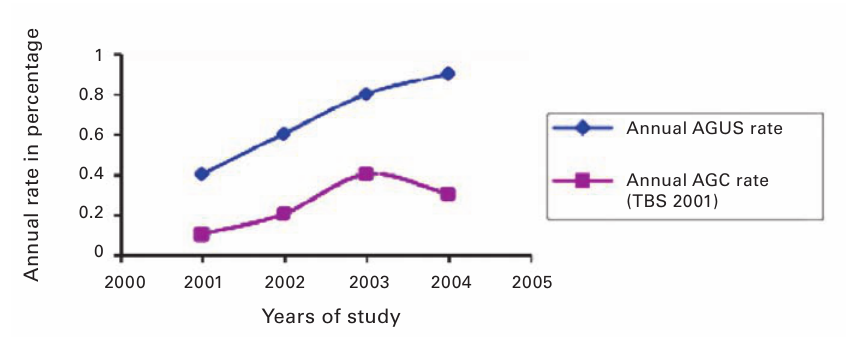
Annual rate for cyto- diagnosis of AGUS (TBS 1991) and AGC (TBS2001) on thin prep Pap test over 4